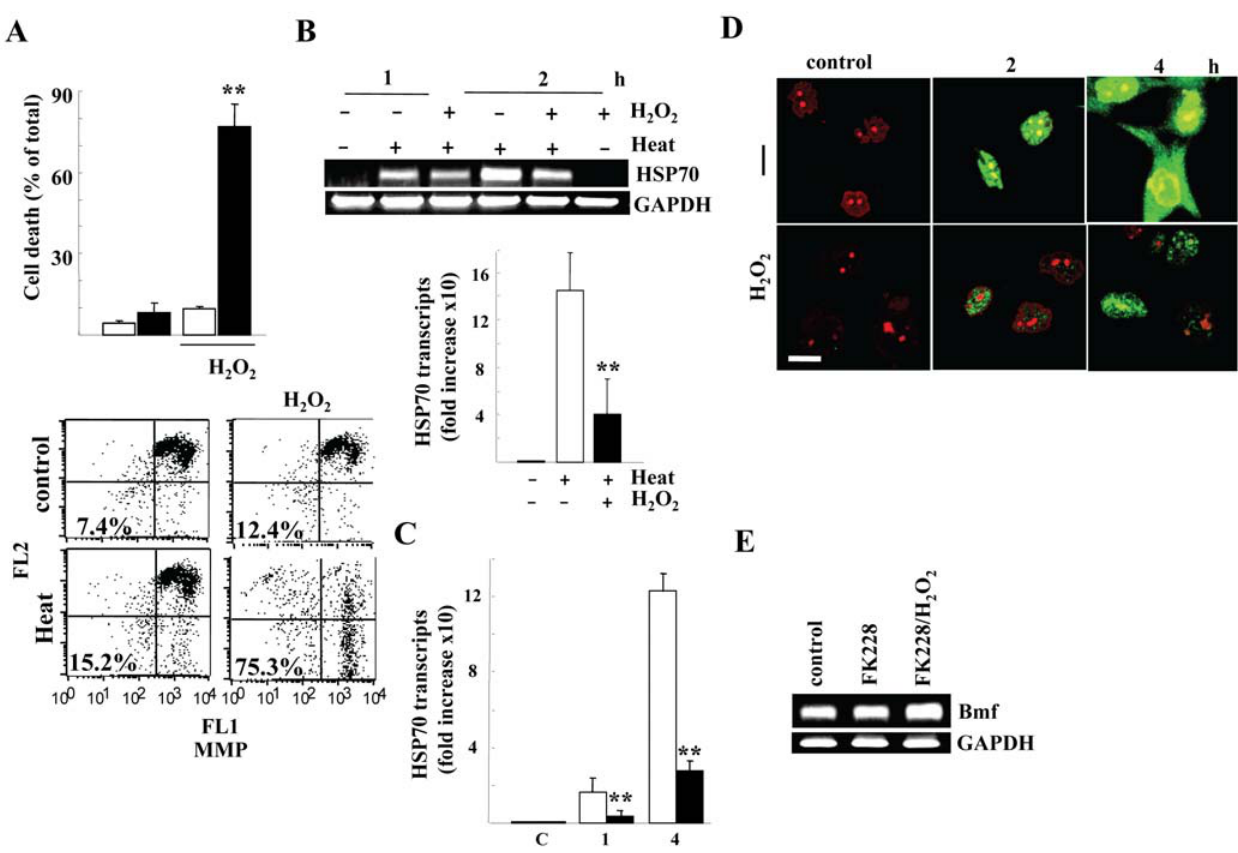
Figure 3. Effect of H 2 O 2 on heat-exposed A172 cells. A ) Cell death at 24 h (upper) and disruption of Dy m (lower panel) at 20 h after heat (44 u c for 20 min) exposure (closed bars) with or without 0.25 mM H 2 O 2 . Numbers indicate % of cells showing loss of Dy m. B ) HSP70 transcripts. Total RNA was harvested from cells treated with the indicated and transcripts of the indicated genes were evaluated by RT-PCR (upper). HSP70 transcripts were determined by real-time PCR and normalized to GAPDH levels (lower panel). C ) Time-course of HSP70 transcripts. At the indicated hours after heat exposure with (closed) or without (open bars) 0.25 mM H 2 O 2 , HSP70 transcripts were determined by real-time PCR and normalized to GAPDH levels In A - C , error bars indicate the mean 6 S.D. of data from three separate experiments and **, P , 0.01 compared with H 2 O 2 -untreated cells. D ) Confocal microscopical detection of HSP70. Cells were pretreated with (H 2 O 2 ) or without (control) 0.25 mM H 2 O 2 and fixed at the indicated hours after heat (44 u c for 20 min) exposure. HSP70 expression was immunohistochemically detected using the anti-HSP70 antibody counter-stained with PI. Bar indicates 10 m m. E ) Bmf transcripts evaluated by RT-PCR of total RNA harvested at 6 h after treatment with the indicated agents for 6 h In B and E , GAPDH mRNA levels ensure that the RNA was correctly